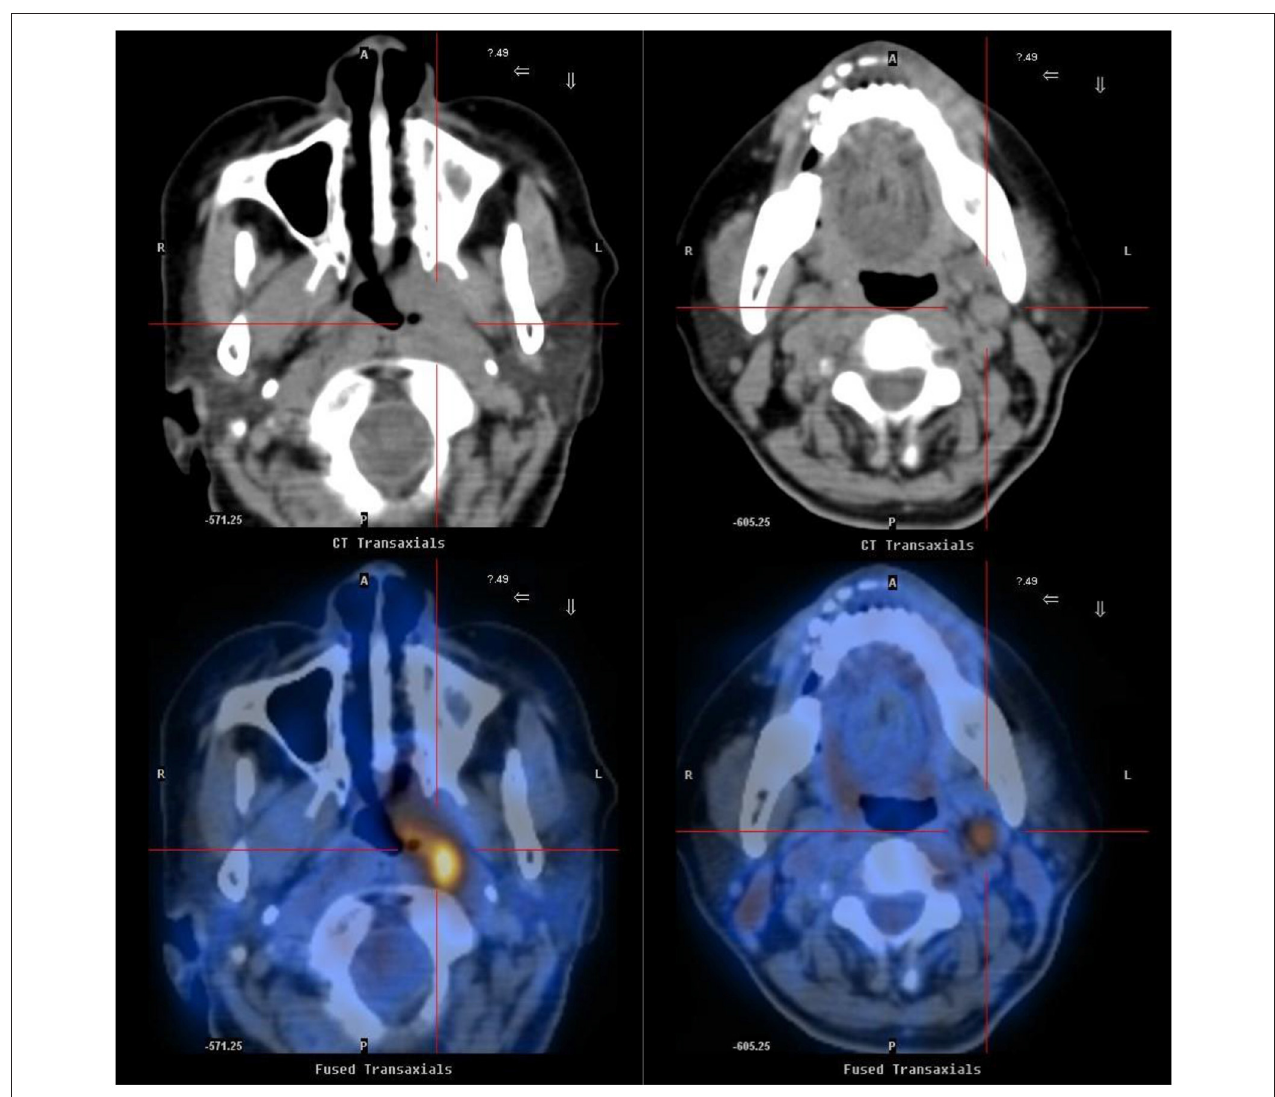
FIGURE 1 | Positron emission tomography (PET) scan shows left nasopharyngeal carcinoma extending to carotid sinus. PET scan demonstrated an increased accumulation of FDG (2-deoxy-2-[18F] fluoro-D-glucose) in the thickening left nasopharynx (left) and an increased accumulation of FDG in the left carotid sheath space